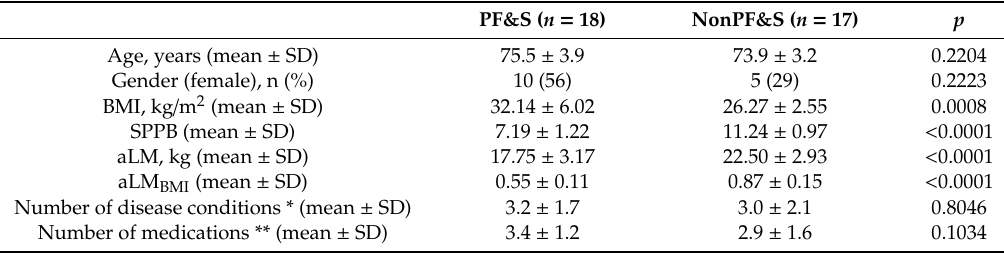
Table 3. Main characteristics of study participants according to the presence of physical frailty & sarcopenia (PF&S).